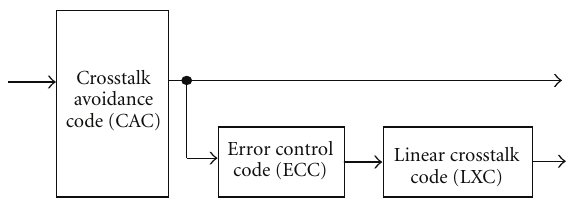
Figure 1: A unified framework for joint crosstalk avoidance code and error correction